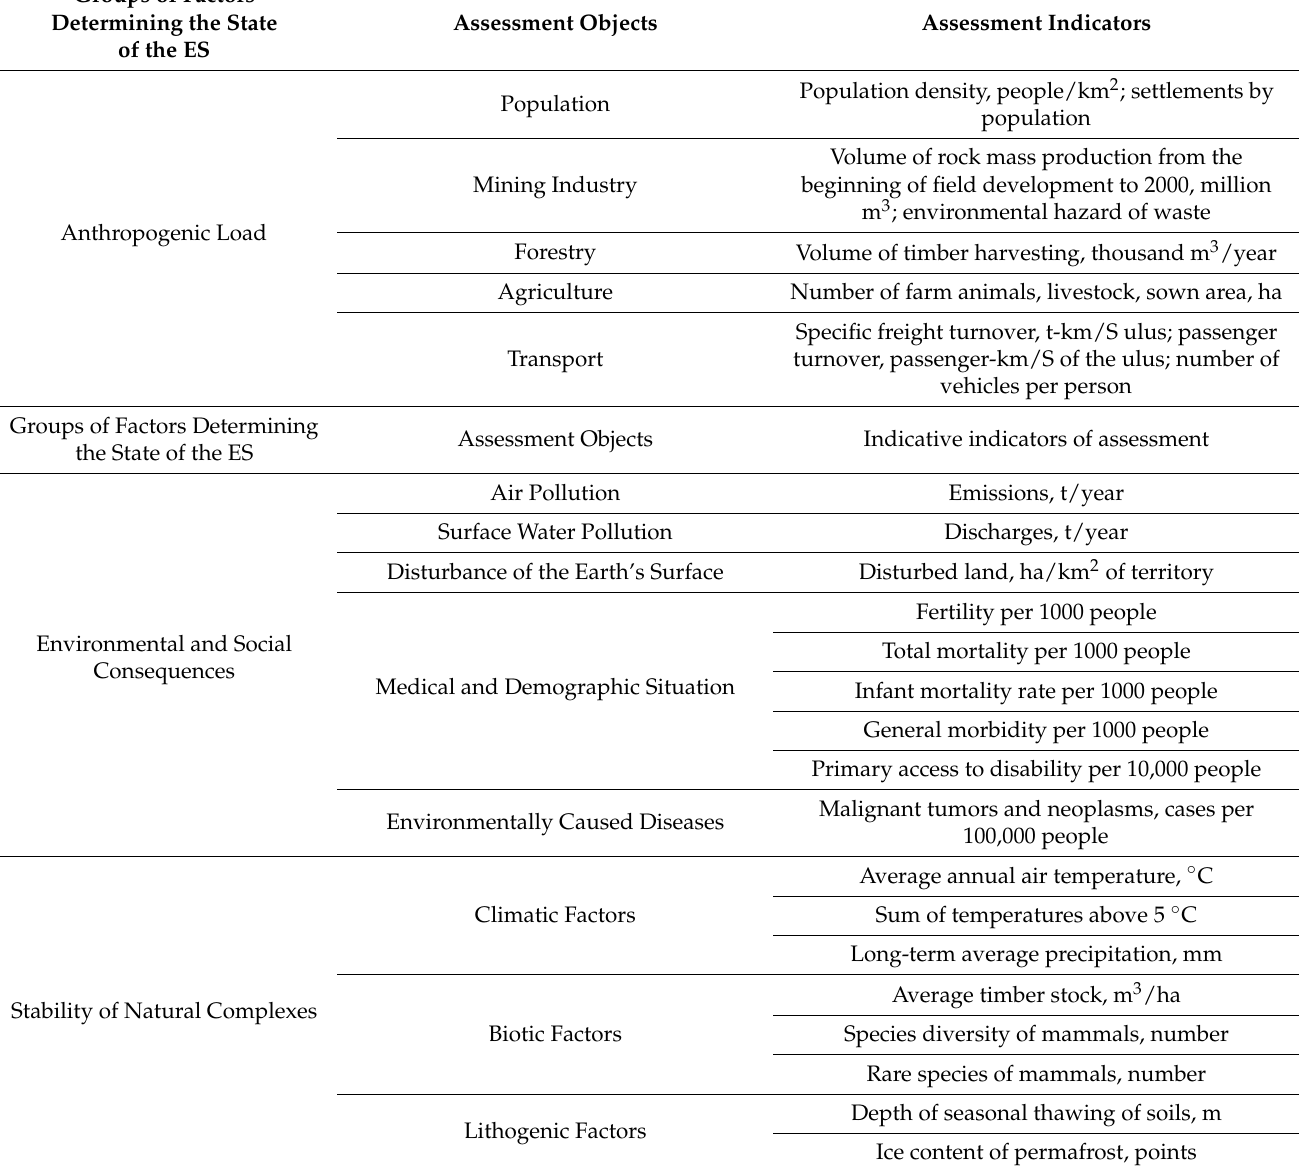
Table 1. Structure of indicators for a comprehensive assessment of the